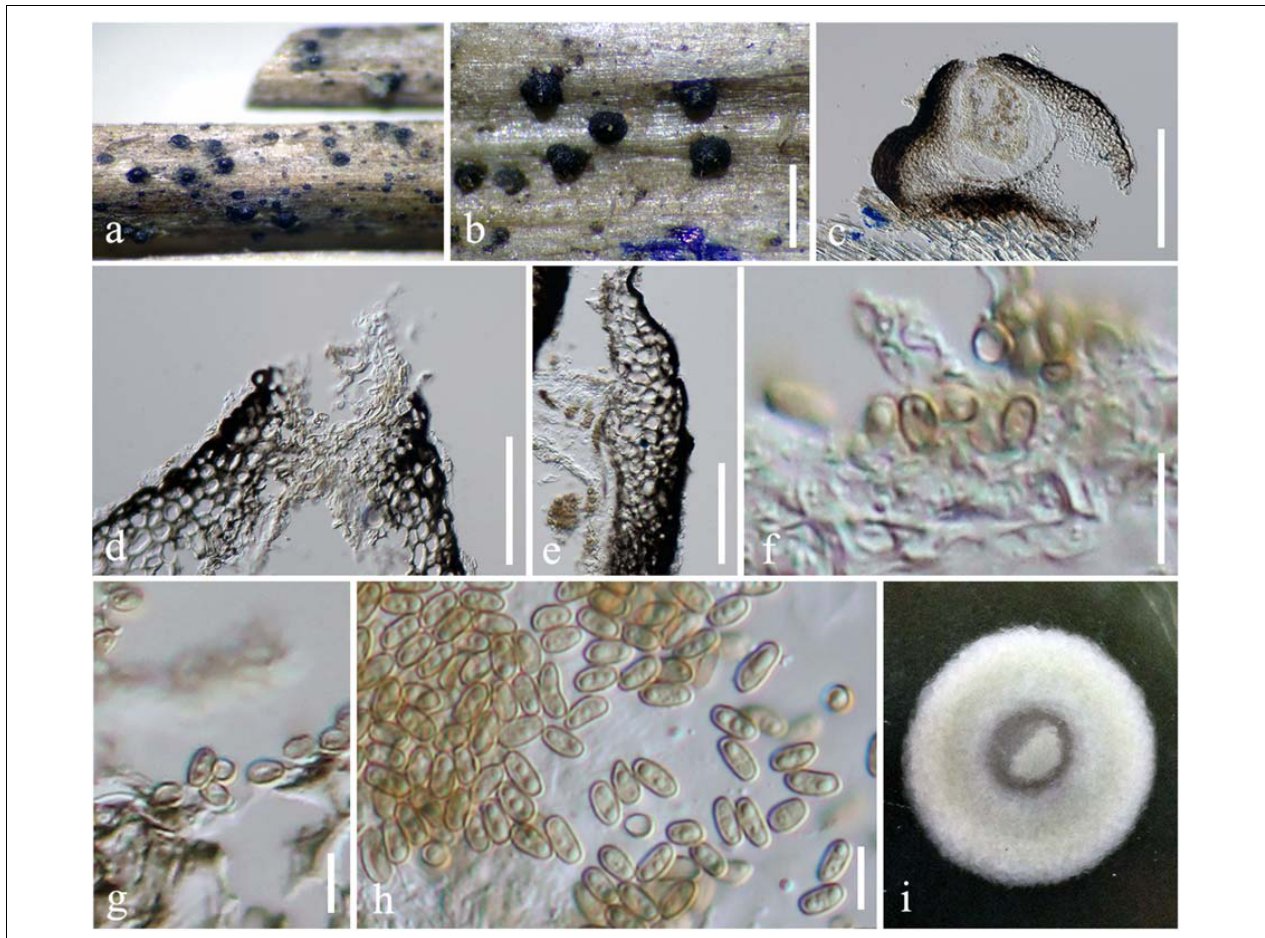
FIGURE 3 | Pseudocyclothyriella clematidis (MFLU 16-0280, holotype). (a,b) Appearance of pycnidial conidiomata on host substrates. (c) Vertical section of conidioma. (d) Ostiole. (e) Pycnidial wall. (f,g) Conidiogenous cells with attached conidia. (h) Conidia. (i) Culture colony on MEA (upper view). Scale bars: (b) = 500 µ m, (c) = 200 µ m, (d,e) = 20 µ m, and (f–h) = 5 µ m.